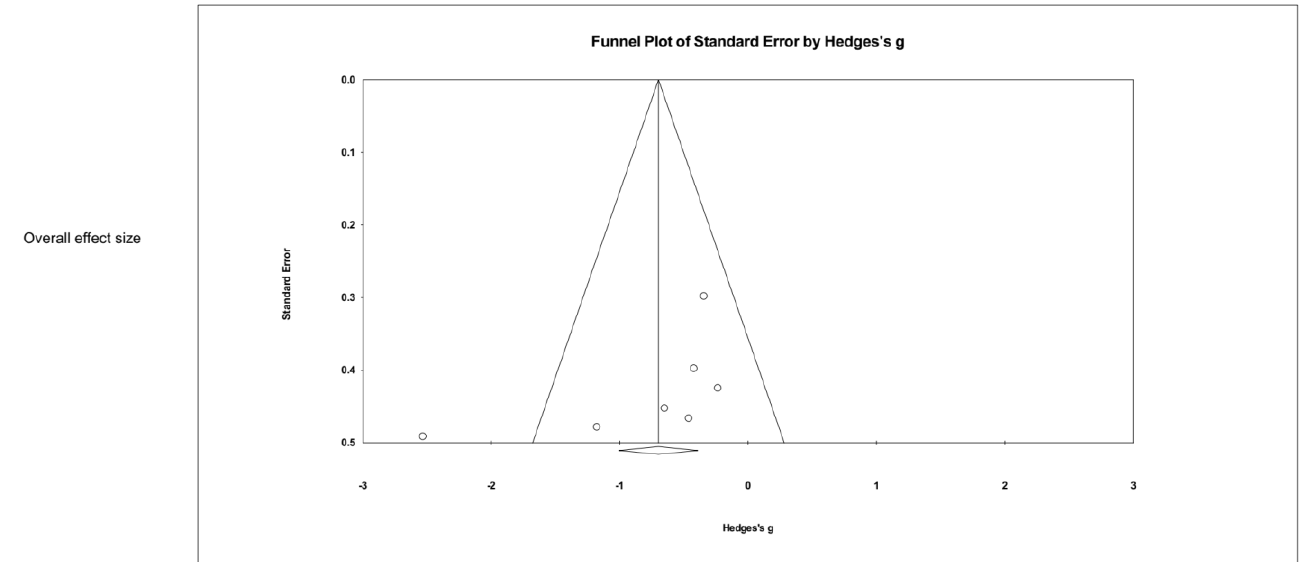
Figure 4. Funnel plot for meta-analysis of the effect of neuro-feedback training on overall PTSD.